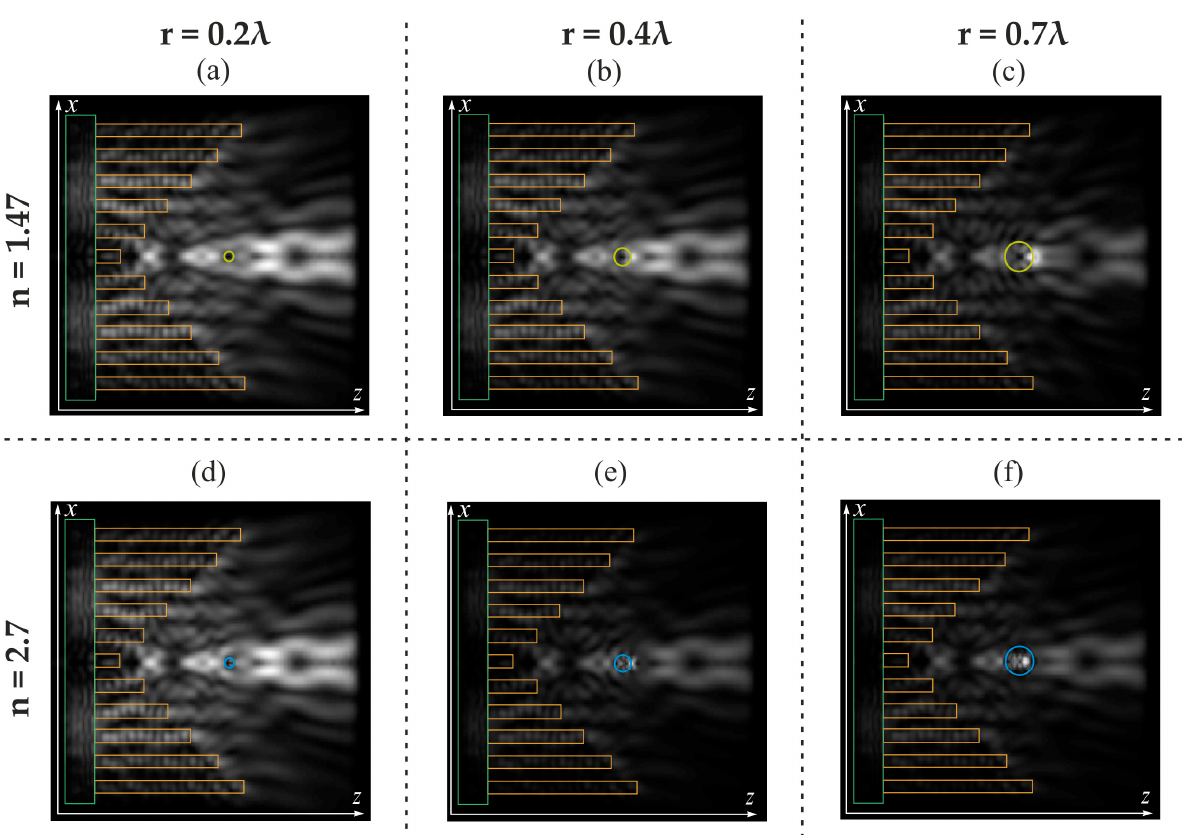
Figure 14. Two-dimensional diffraction pattern of the Laguerre–Gaussian mode (1,0) (see Figure 12) with a particle in the second trap: particle with n = 1.47 ( a – c ); particle with n = 2.7 ( d – f ).